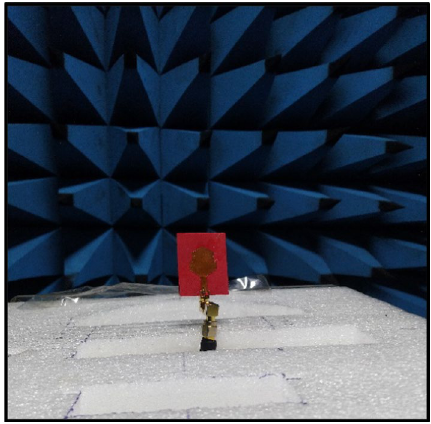
Fig. 6 Photograph of anechoic chamber set up. An anechoic chamber is used to measure the antenna radiation pattern, as seen in this figure. The antenna radiation is measured with the help of an anechoic chamber of size 7.5 m 5 m 3.3 m. The antenna is set up for far-field measurement over the distance of × × 5 m for the antenna under test (AUT) and the reference antenna. This anechoic chamber provides effective shielding and allows an interference-free testing environment